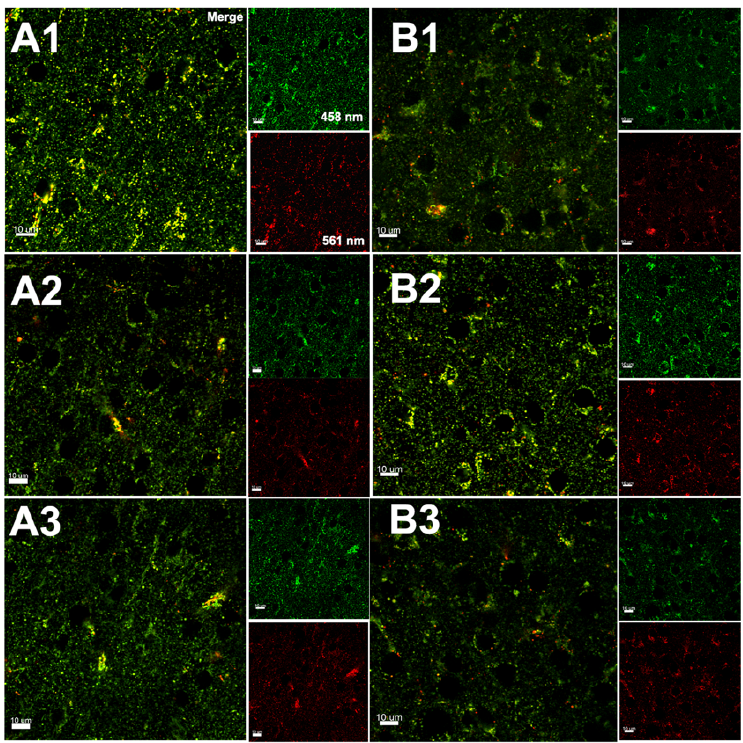
Figure 5. Assessment of mitophagy 24 h after HI in the brain tissue of mt-Keima mice by super- resolution microscopy. ( A1 – A3 ): Injured hemisphere, ( B1 – B3 ) uninjured hemisphere; serial sections are visualized at 100 μ m intervals of both hemispheres. ( A1 – B3 ): Merge, red channel: excitation at 561 nm, green channel: excitation of 458 nm.